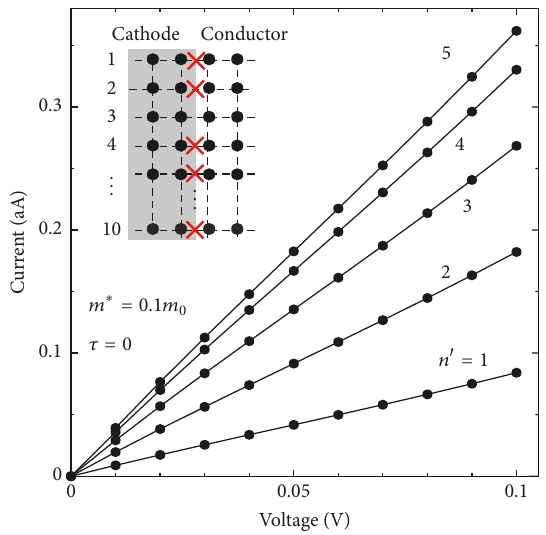
Figure 5: Change in resistance (𝑅 𝑛 − 𝑅 0 )/𝑅 0 for 𝑚 ∗ = 0.1𝑚 0 is plotted by dots as a function of defect position 𝑛 for the width 𝑁 𝑤 = 10 ∼ 14. Curves are results of fitting to (9). Inset: coefficient |𝐶 𝑛 | in (9) evaluated by the least square fitting.